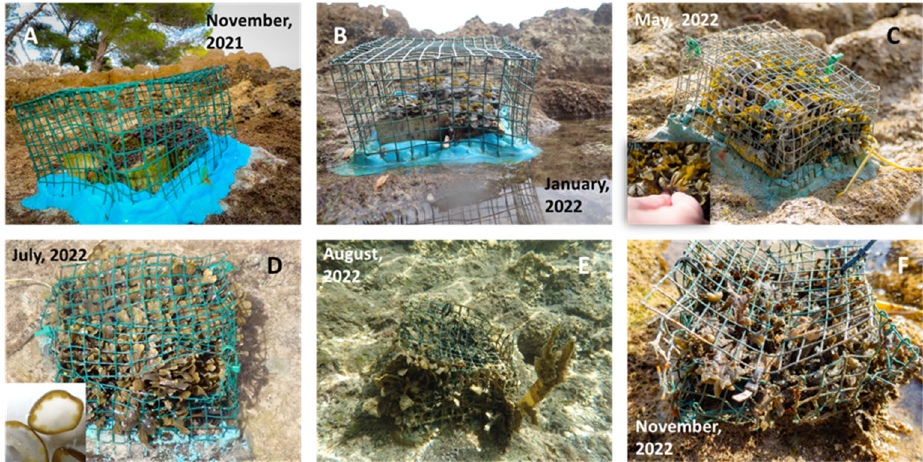
Figure 3. Post planting growth of Fucus virsoides over a one-year period. Photographs were taken in November 2021 ( A ), January 2022 ( B ), May 2022 ( C ), July 2022 ( D ), August 2022 ( E ) and November 2022 ( F ).